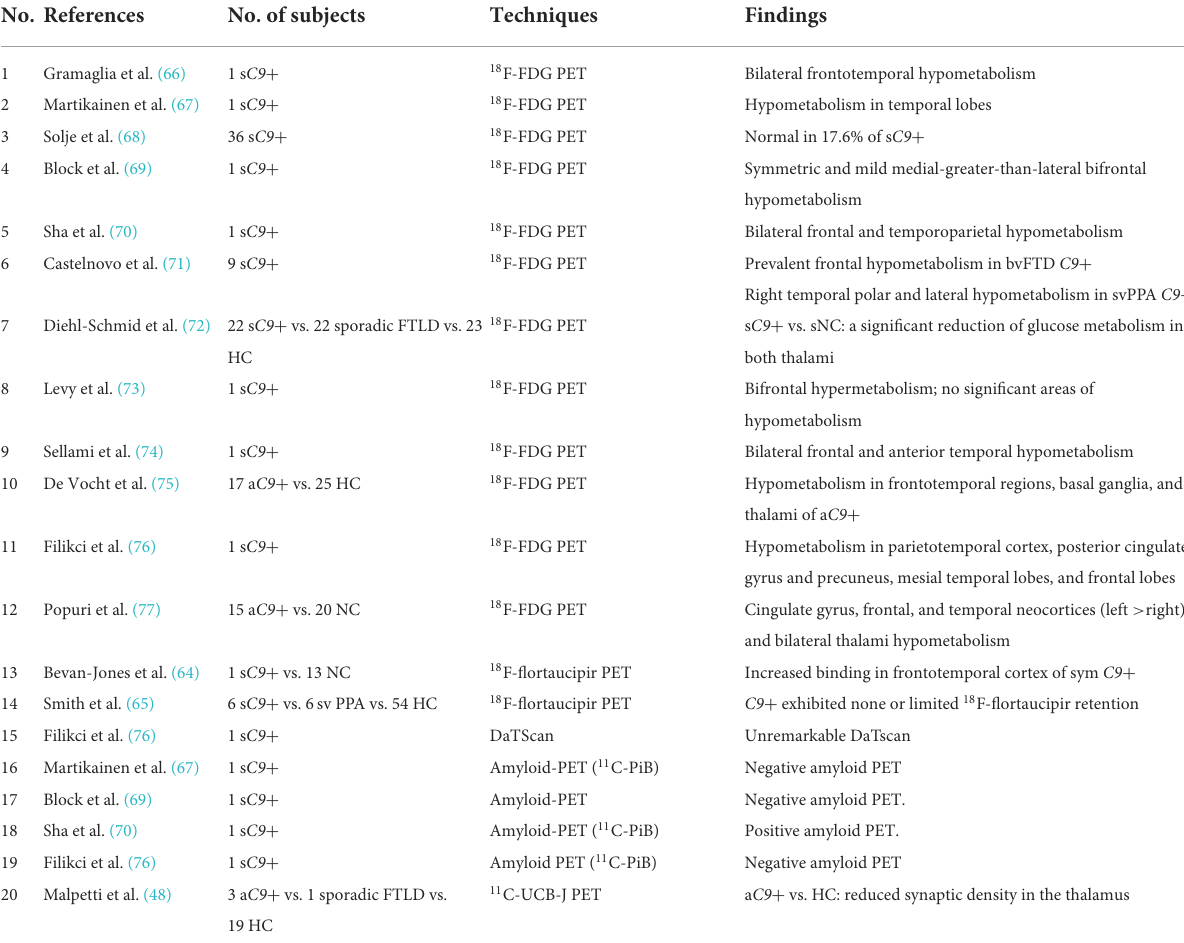
TABLE 3 Studies investigated asymptomatic/symptomatic C9